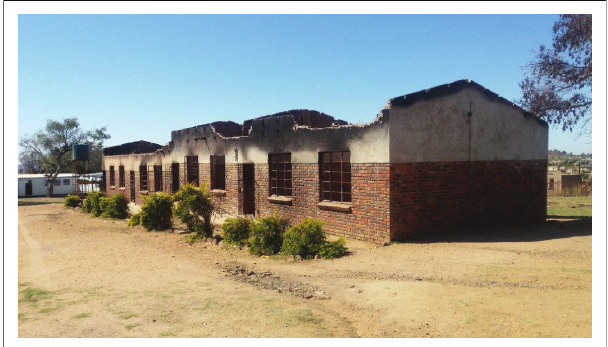
FIGURE 2: All 21 classrooms of the Vhafamadi Secondary School were torched. The department provided temporary classrooms.